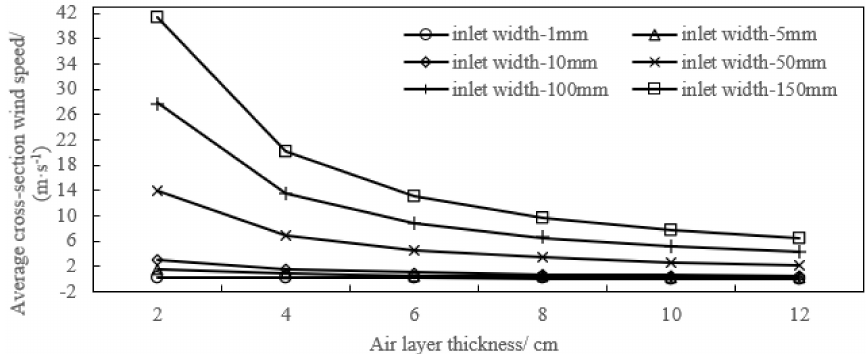
Figure 6. Average cross-section wind speed variation with the thickness of the air layer.